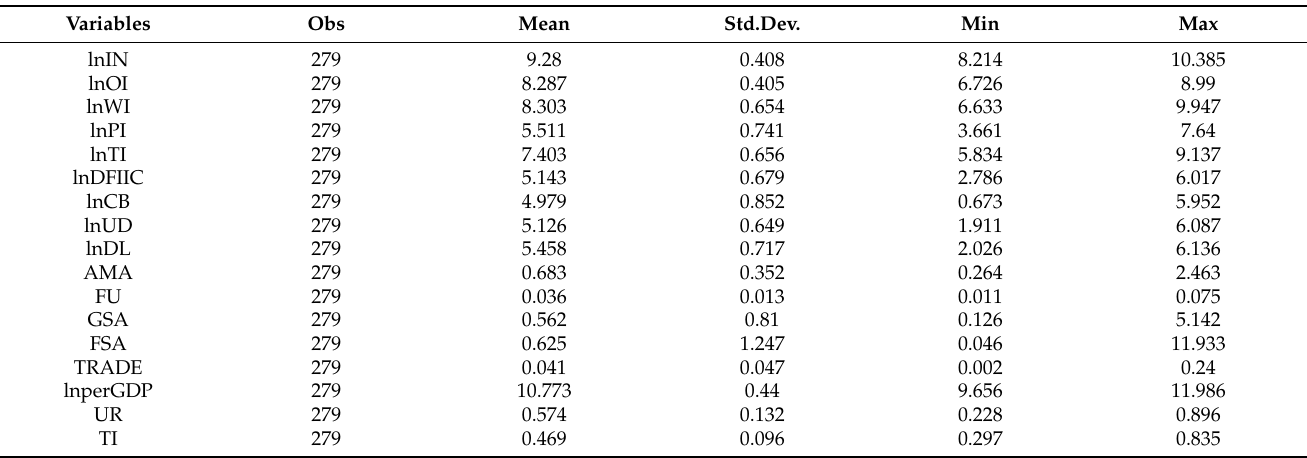
Table 2. Descriptive